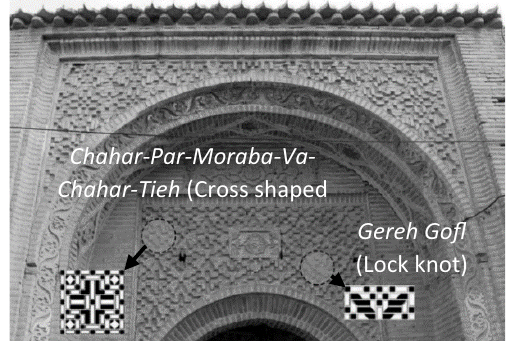
Fig. 1 Xowun decoration in Sohrabi house in Dezful